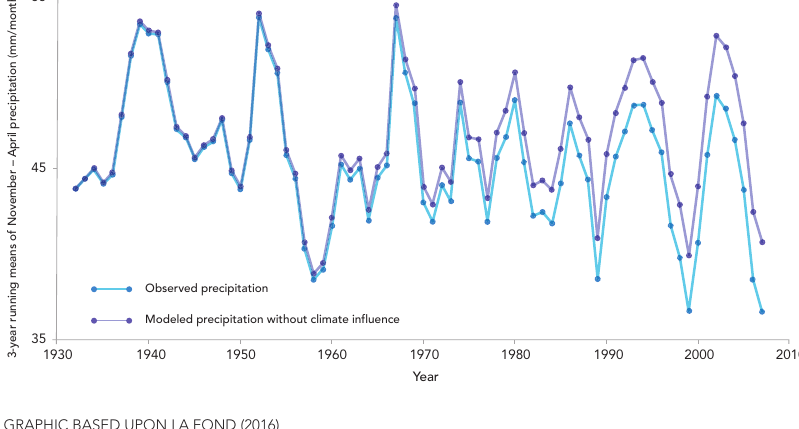
Figure 2. Separating the influence of climate change (1932–2007): Using measurements of carbon dioxide concentrations in the atmosphere coupled with climate models and statistical analysis, scientists were able to estimate what rainfall in the Fertile Crescent would have looked like without the influence of climate